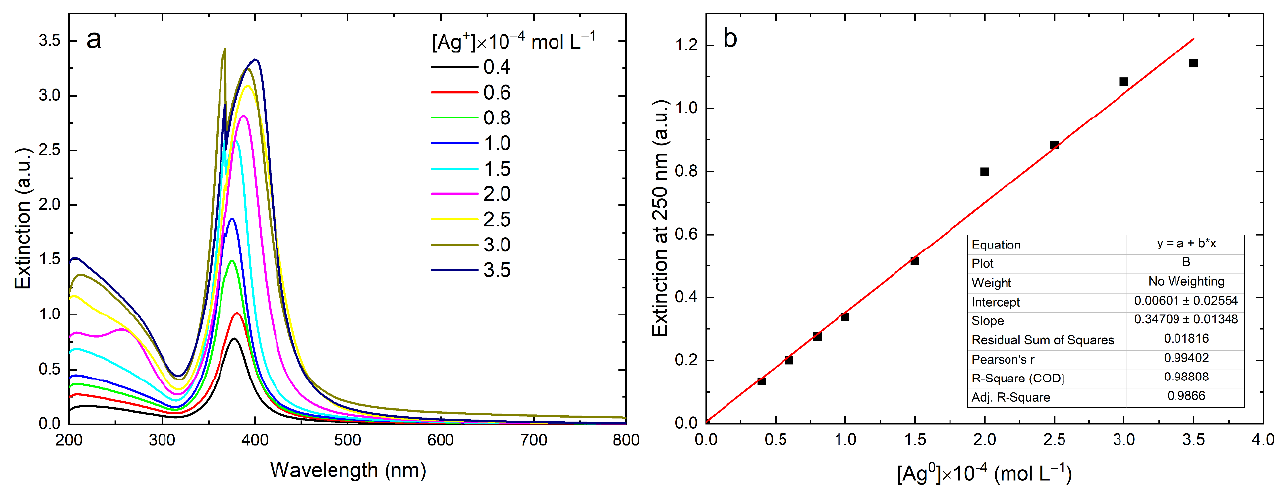
Ag + with NaBH 4 in the presence of NaPp ( a ); IBT absorption at 250 nm as a function of Ag 0 concentration ( b ). Solution: Ag + (0.4–3.5) × 10 –4 mol L –1 and NaPp 2 × 10 –4 mol L –1 ( b ). Optical path length: 10 mm.